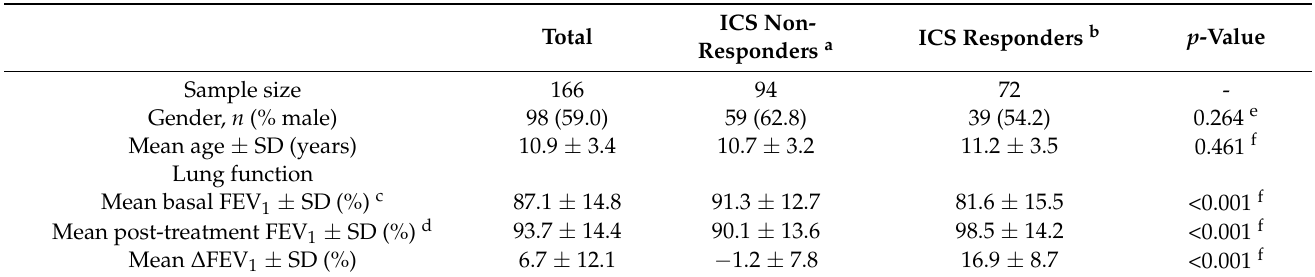
Table 1. Clinical and demographic characteristics of the asthma patients from the SLOVENIA study included in the GWAS of change in FEV 1 after ICS treatment.